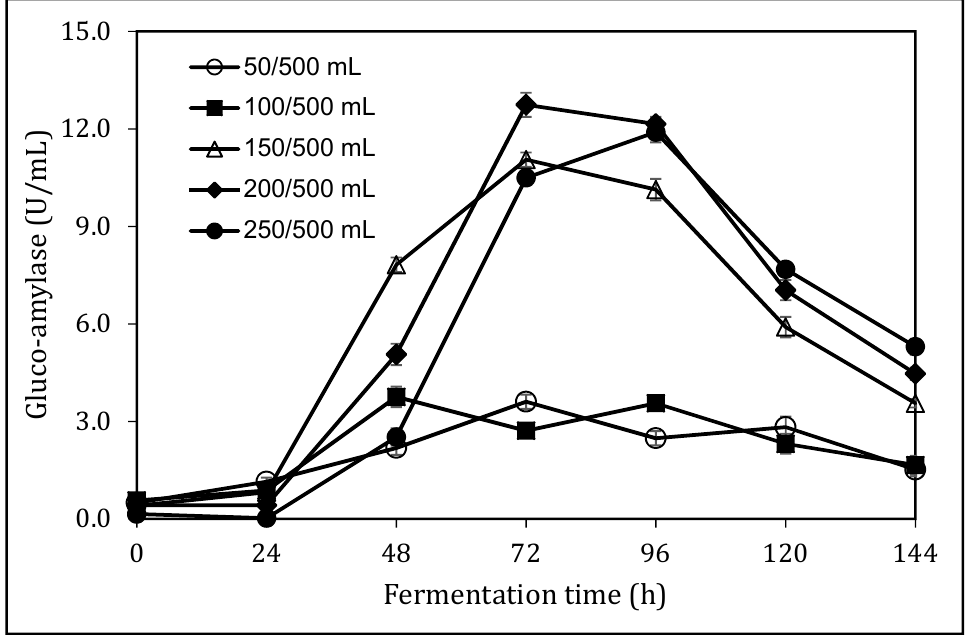
Figure 4. The effect of medium loading ratio on glucoamylase production. Fermentation was carried out at 28 °C, 10% (w/v) sorghum bran, with mineral solution C, at pH 6.0.